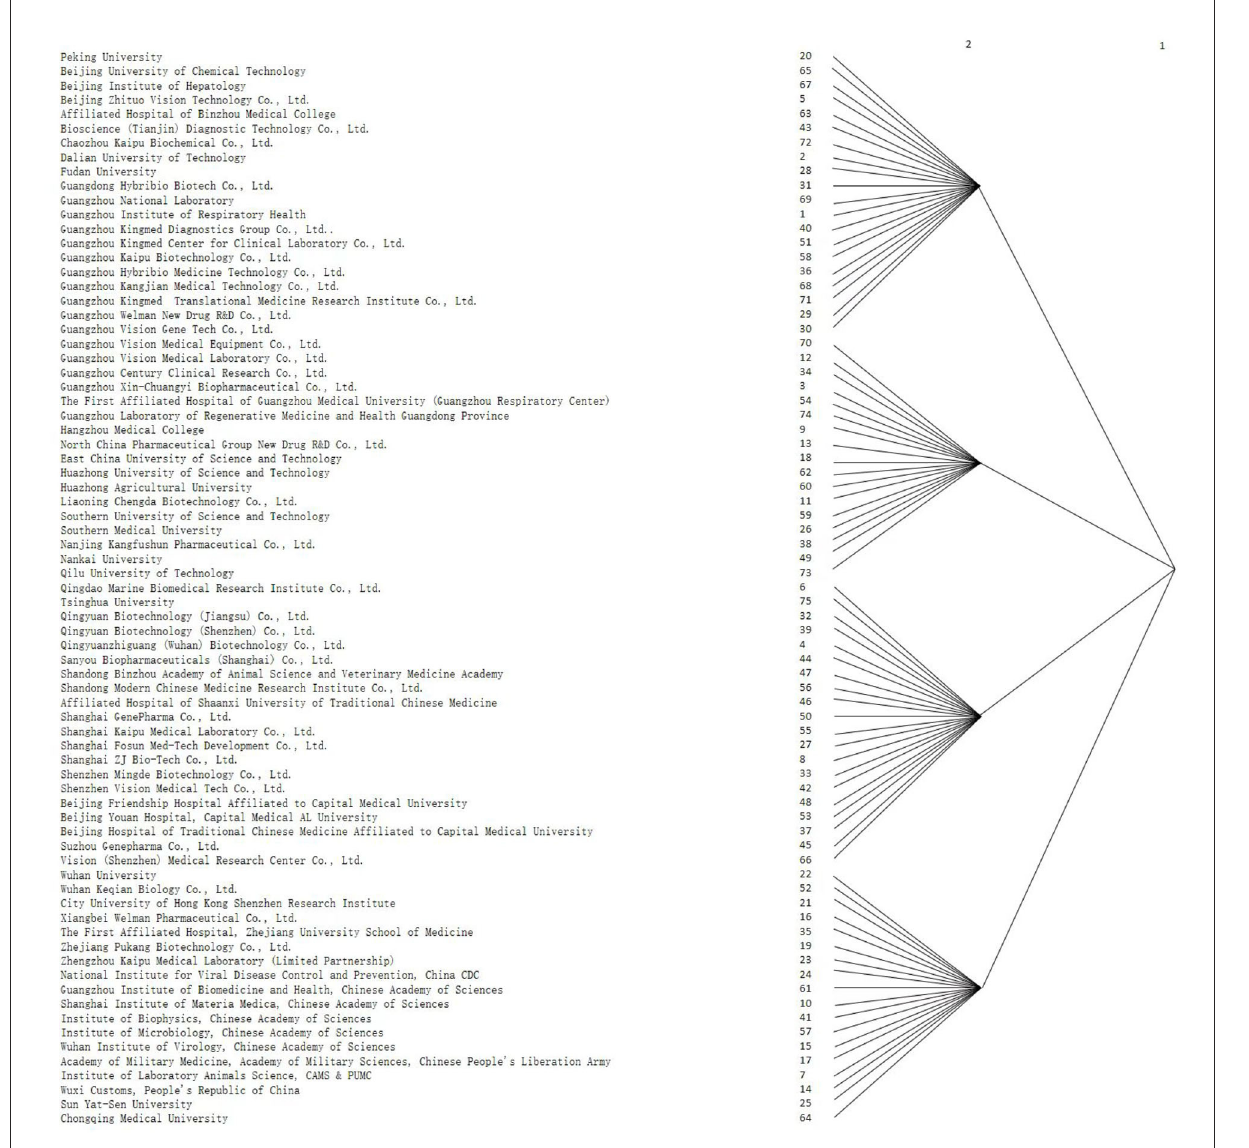
FIGURE2 Cohesive subgroups in the COVID-19 patent cooperation